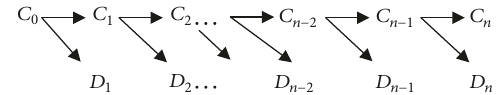
Figure 3: The wavelet decomposing process of output dataset.